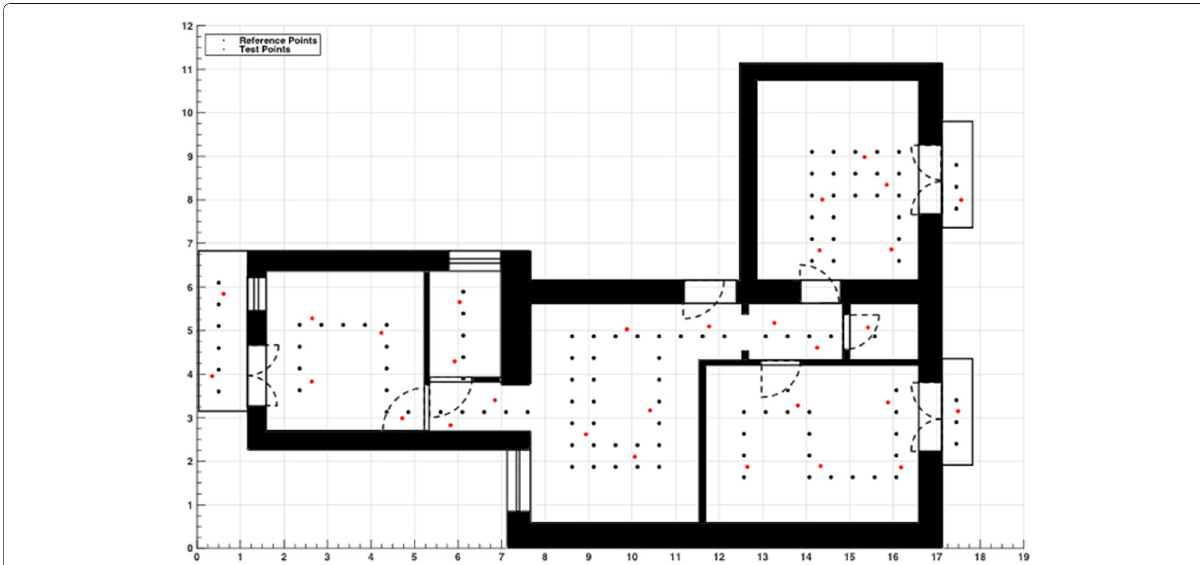
Fig. 6 Indoor experimental layout. The indoor experimental area is an apartment of 90 m 2 , which has been mapped by 113 reference points (black points) and 30 test points (red points)